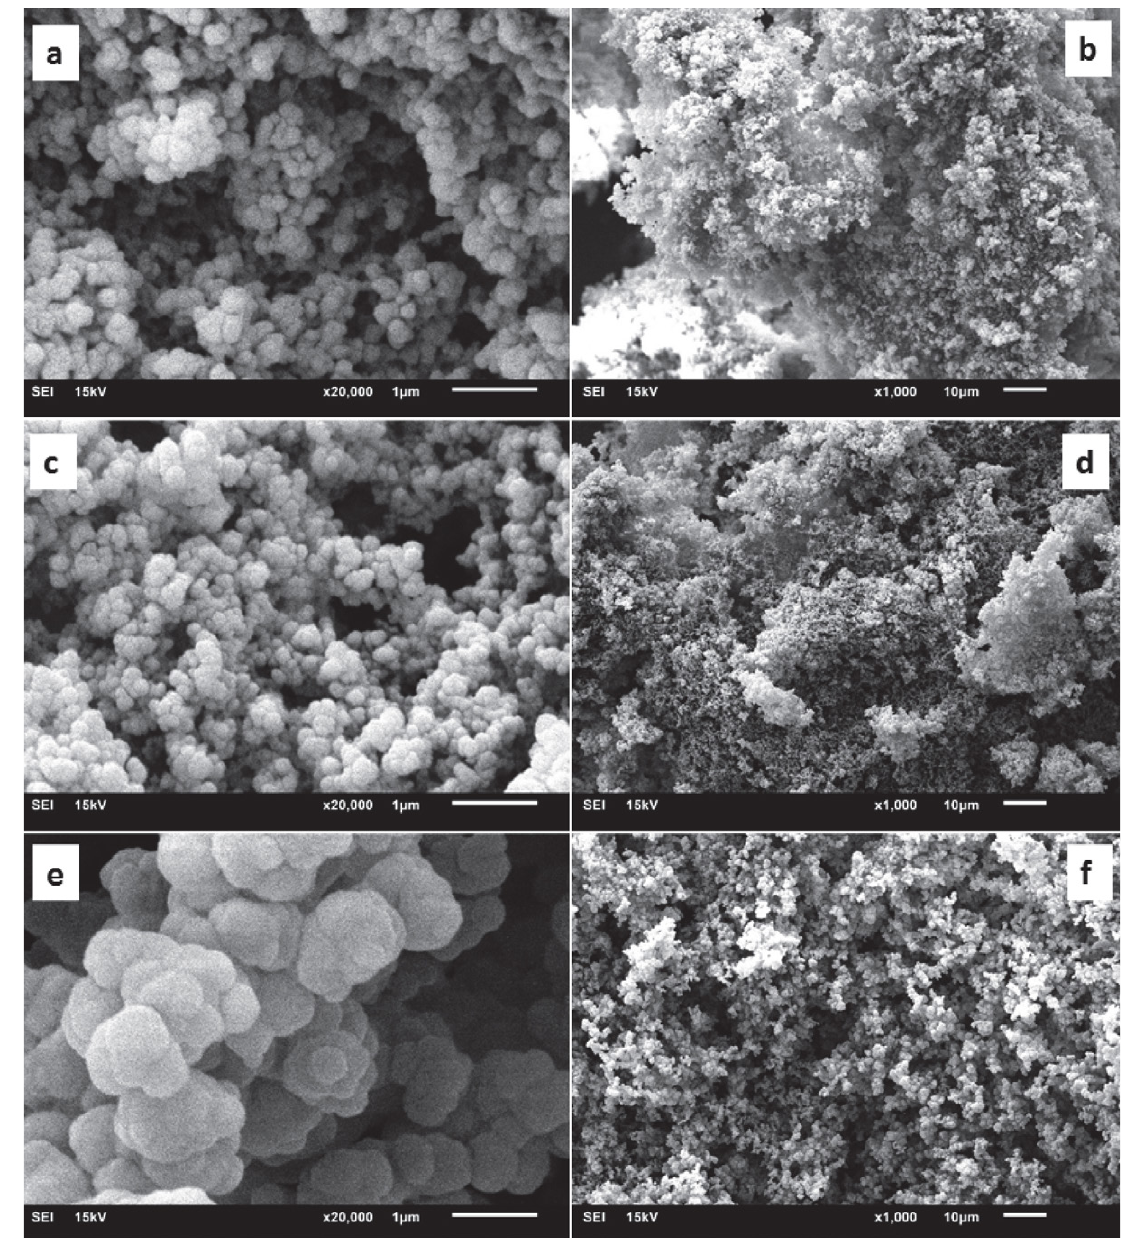
Figure 2. SEM images of the DOP-P (a, b), DOP-IP (c, d), and NIP (e,